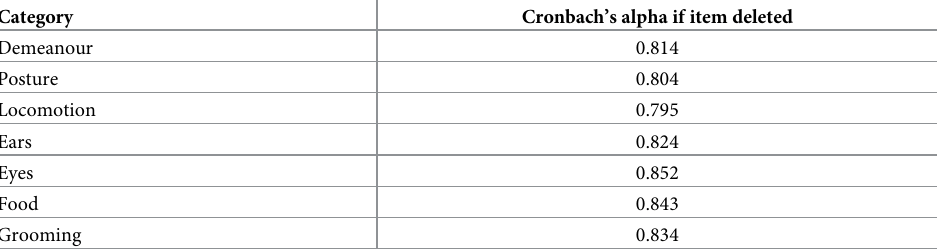
Table 5. The internal consistency of the BRPS was analysed using the Cronbach’s alpha test. The table shows the Cronbach’s alpha of the scale if each item would be deleted.